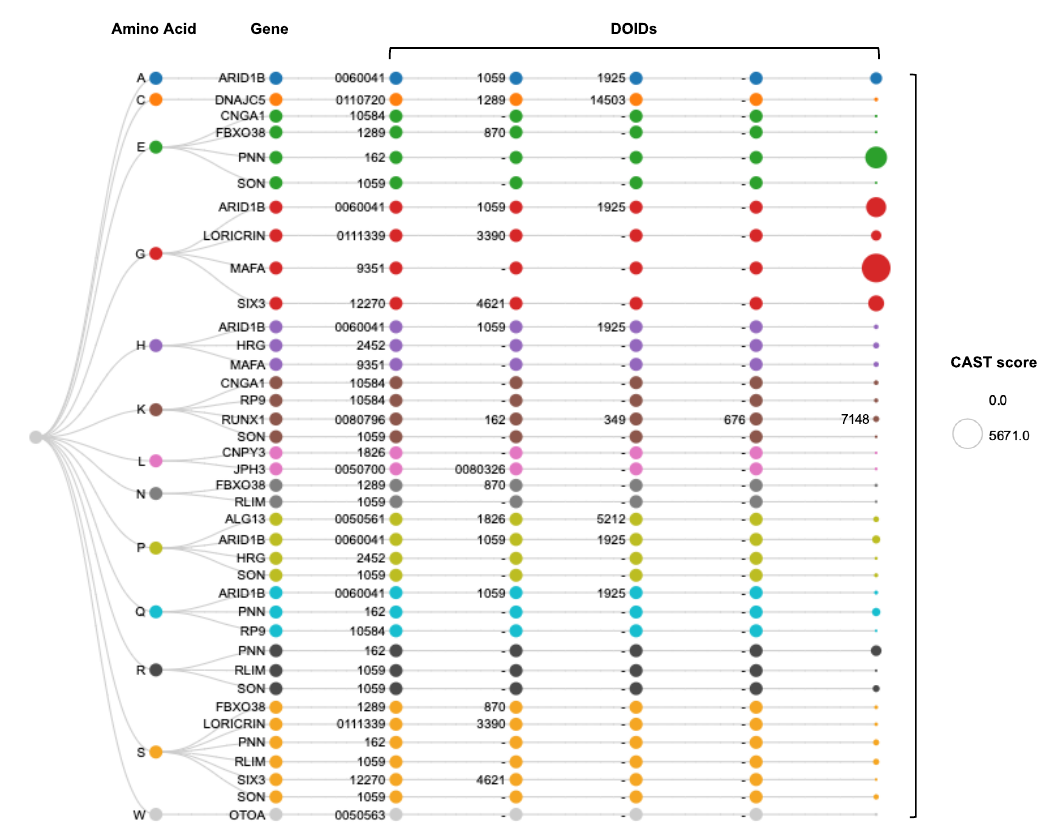
Figure 3. The 17 disease-associated genes from the set of 100 human proteins with well-characterised compositionally biased regions, linked to associated DOIDs. The first column corresponds to the amino acid thatappearstohaveenrichedpresencein eachcase.Thelastcolumn ’ ssizeisproportional tothesum ofCASTscores for amino acid rich regions in each gene. Although specific genes have originally been listed as exemplary for one compositional bias type, in this analysis they can be observed more than once along their DOID associations, as the result of CAST analysis for the derivation of total scores. DOID=Disease Ontology identifier.